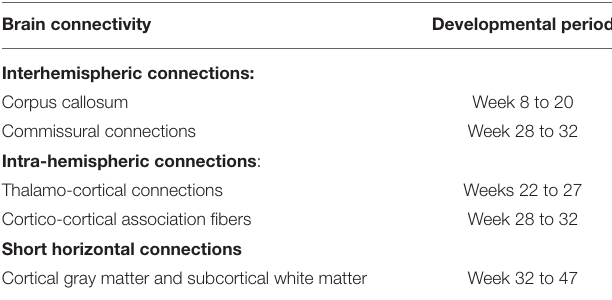
TABLE 1 | Developmental period of brain